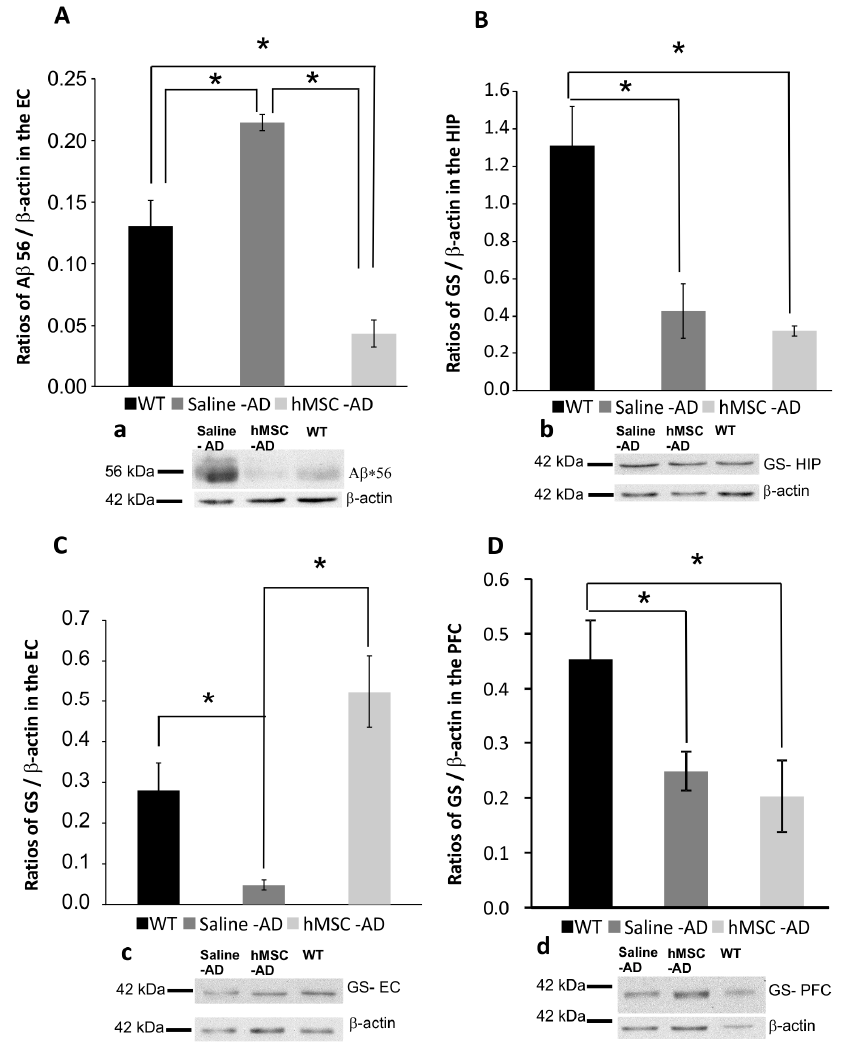
Figure 2. Western blotting demonstrated that the levels of A β *56 were reduced in the entorhinal cortex after hMSC transplantation ( A ); The levels of glutamine synthase (GS) in the hippocampus ( B ) and prefrontal cortex ( D ) were significantly reduced compared to WT controls in both hMSC-treated and saline-treated 3xTg-AD mice. In contrast, the entorhinal cortex showed preserved levels of GS in hMSC-treated mice compared to saline-treated animals ( C ). Western blots are shown in a , b , c , and d , respectively. * p < 0.05. HIP: hippocampus; PFC: Prefrontal cortex; EC: Entorhinal cortex. Astrocytes are principal protectors against excitotoxicity and are key elements in glutamate homeostasis and metabolism. Glutamate taken up by astrocytes (by the glutamate transporters